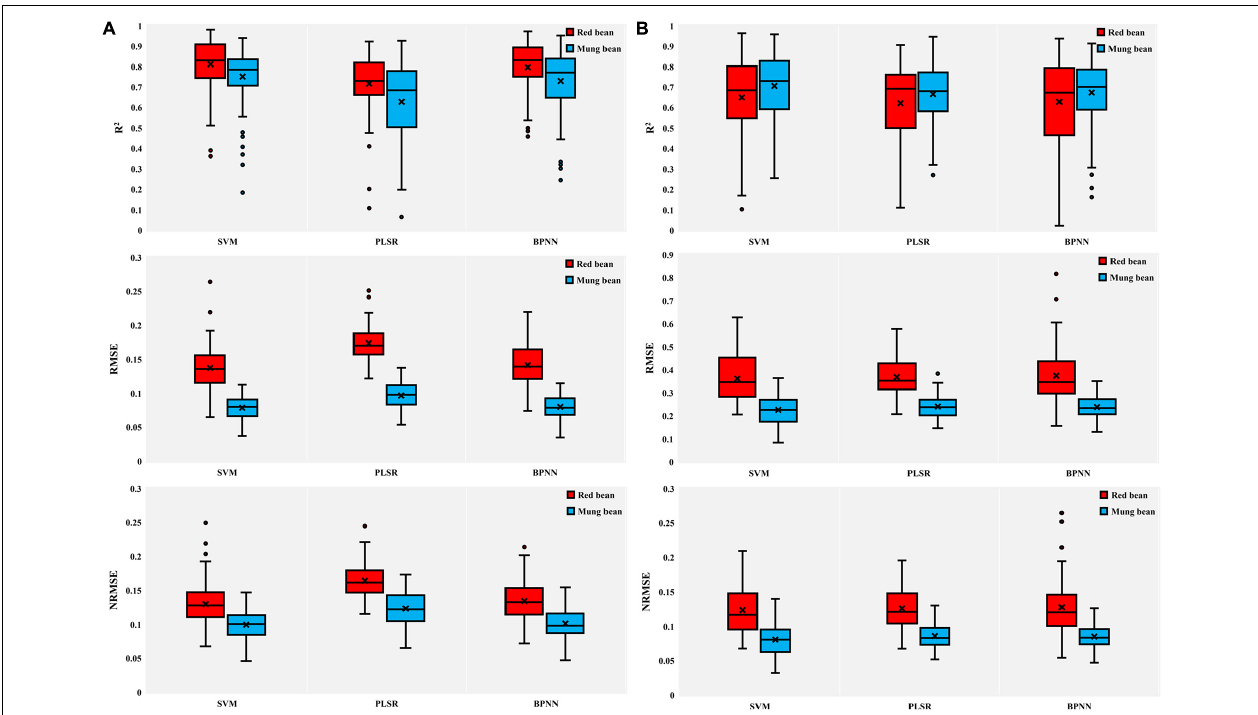
FIGURE 7 | Box plots of coefficient of determination ( R 2 ), RMSE, and NRMSE of test results of SVM, PLSR, and BPNN. (A) AGB of red bean and mung bean; (B) LAI of red bean and mung bean. The point plots indicate outliers encountered during the phase of the 100 different test repetitions and the black multiplication sign indicates the mean value.